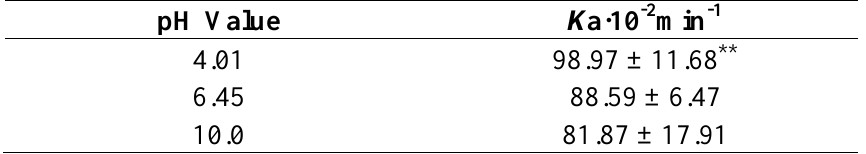
Table 3. K a of paeonol nasal absorption with different pH ( n = 5, mean ± S.D.).